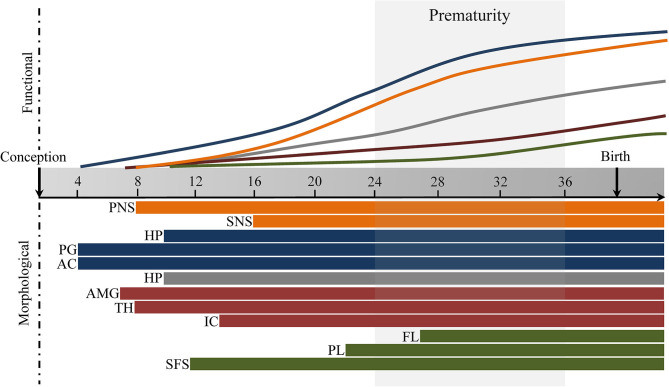
Fetal development of stress-response and stress-regulatory brain networks for illustration purposes. Autonomic Nervous System (orange), Hypothalamic-Pituitary-Adrenal axis (blue), Salience Network (red), Executive Control Network (green). PNS, parasympathetic nervous system, SNS, sympathetic nervous system, HPT, hypothalamus, PG, pituitary gland; AC, adrenal gland; HP, hippocampus; AMG, amygdala; TH, thalamus; IC, insular cortex; FL, frontal lobe; PL, parietal lobe; SFS, superior frontal sulcus. Timing based on literature reviewed under section Pre- and Post-natal Brain Development of Stress Systems and Brain Networks. Default Mode Network (gray).